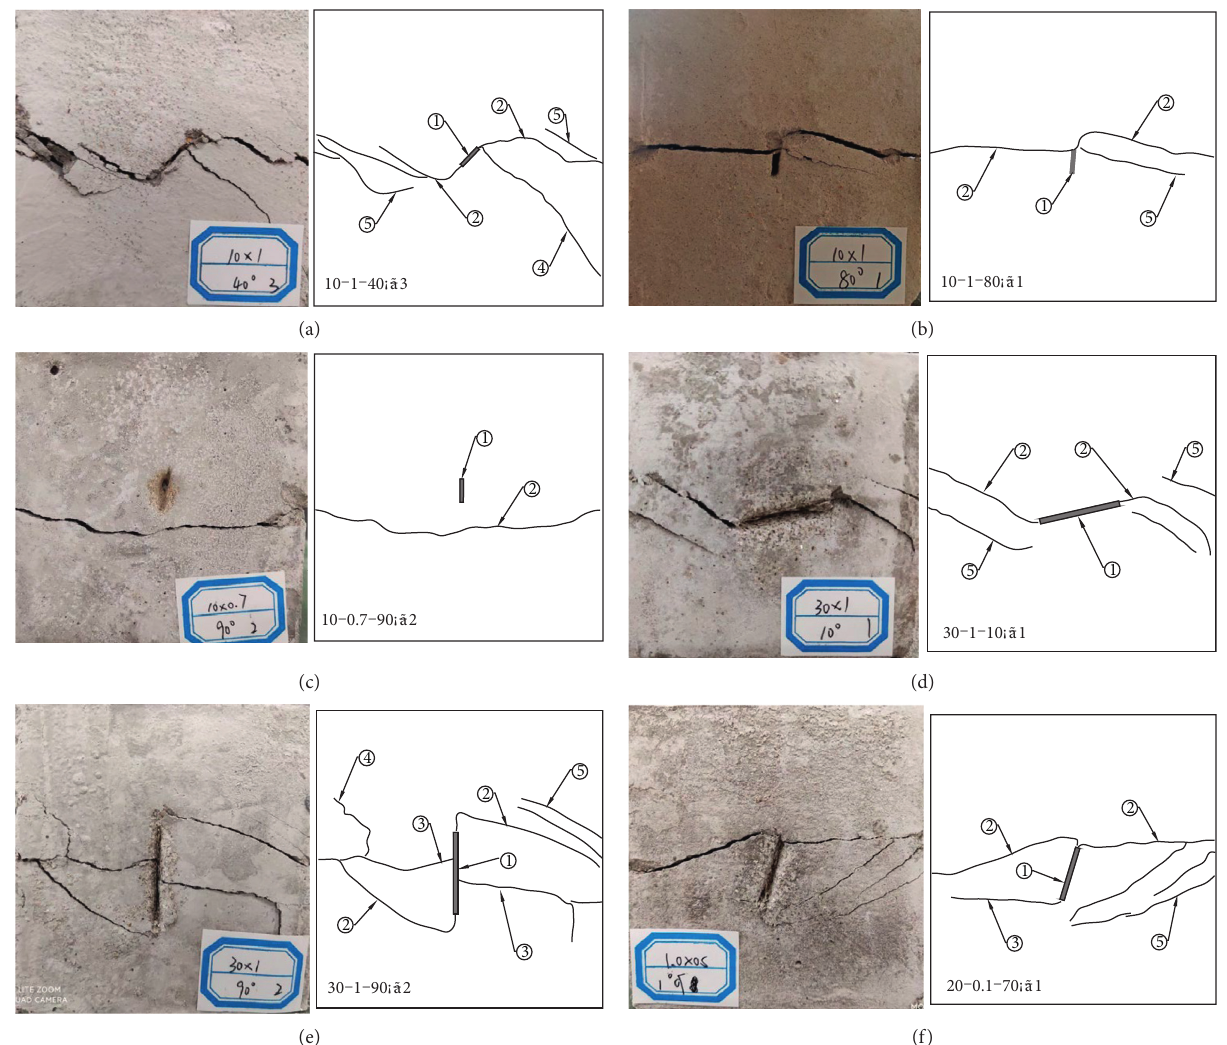
Figure 9: Test results on the length of the prefabricated fissure and crack coalescence mode. Note: ① prefabricated fissure; ② shear crack; ③ secondary shear crack; ④ secondary tensile crack; ⑤ secondary tensile-shear